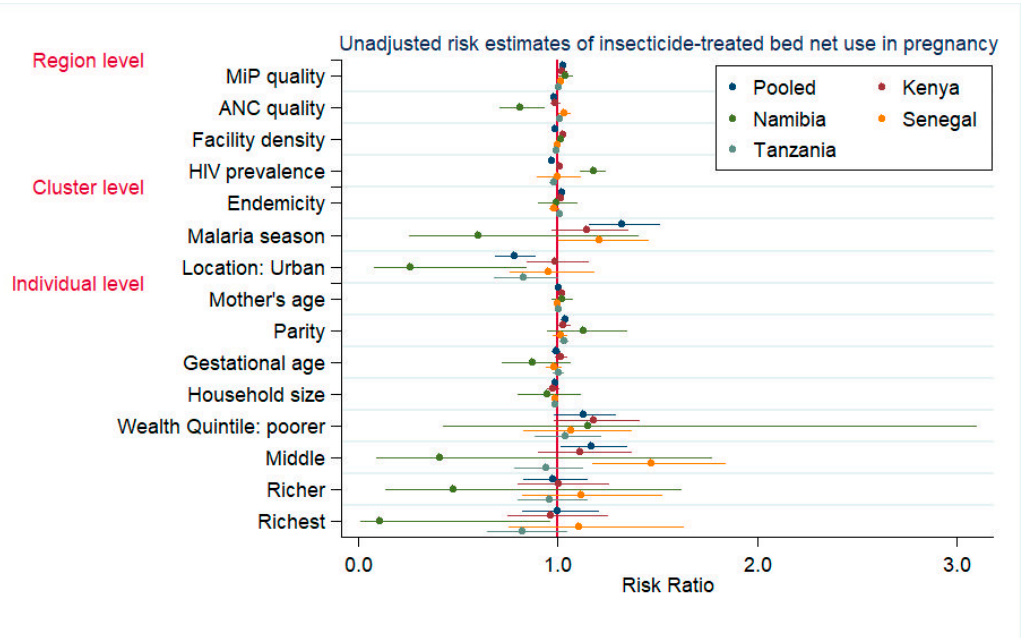
Figure 2. Unadjusted risk estimates for insecticide-treated bed net use in pregnancy. Note: Unadjusted risk estimates of mother’s educational level not shown. Table 4. Adjusted multilevel mixed effects modified Poisson results for insecticide-treated net use in pregnancy.